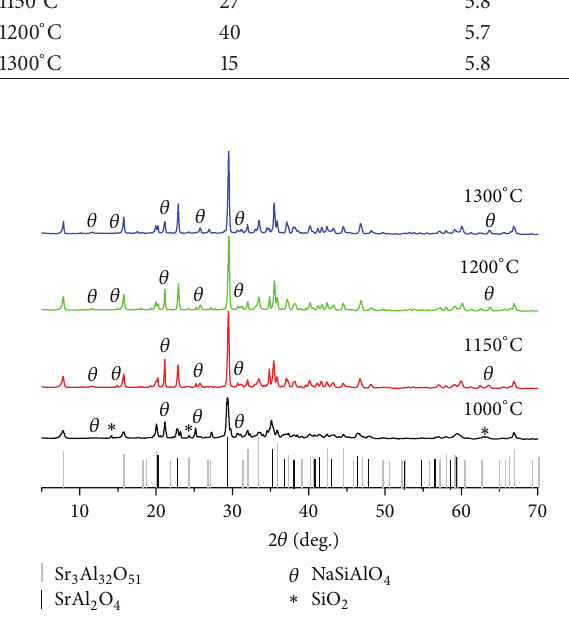
Figure 1: XRD patterns of the samples as function of temperature.